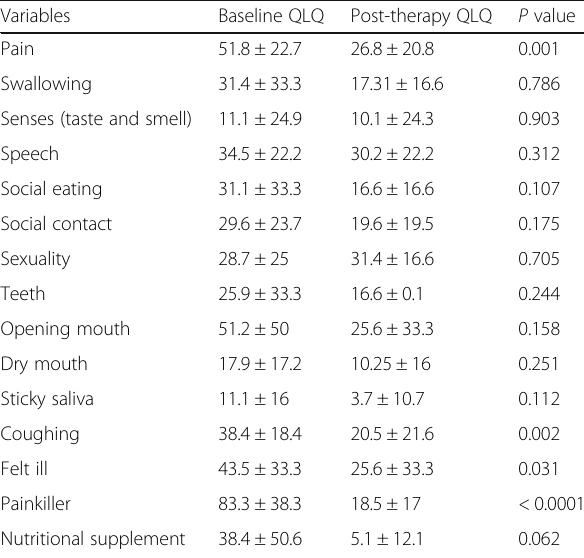
Table 5 EORTC QLQ-H&N35 scoring in the morphologically stable head and neck paraganglioma assessed at the onset and end of the assessment